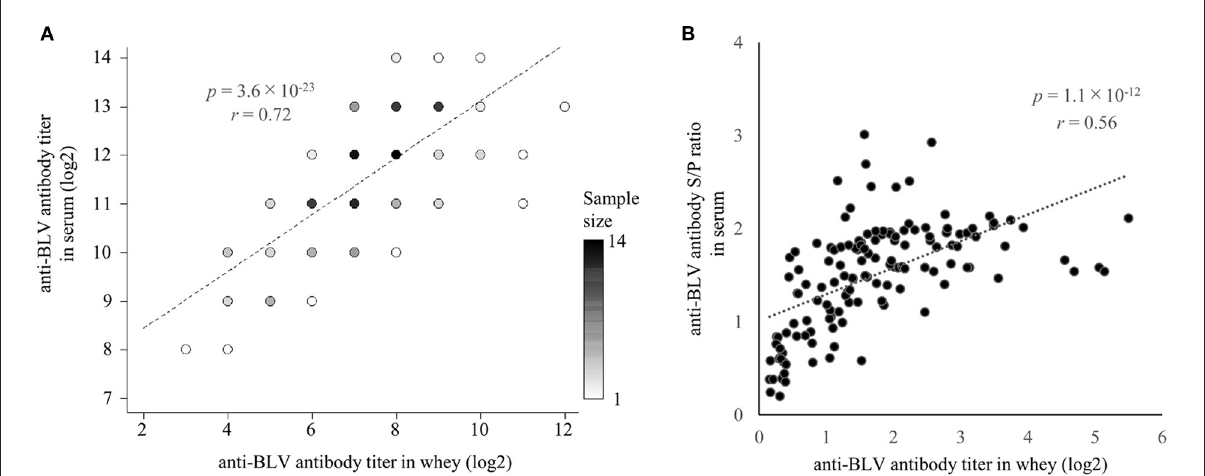
FIGURE2 The correlation between anti-bovine leukemia virus (BLV) antibody presence in whey and serum. Anti-BLV antibody titers, S/P ratios at 32-fold dilution in whey, and S/P ratios at 512-fold dilution in serum were measured using an anti-BLV antibody ELISA. (A) Correlation between anti-BLV antibody titer in whey and serum ( n = 137). Dot color shows sample size. (B) Correlation between anti-BLV antibody S/P ratios for 32-fold dilution in whey and 512-fold dilution in serum ( n = 137).